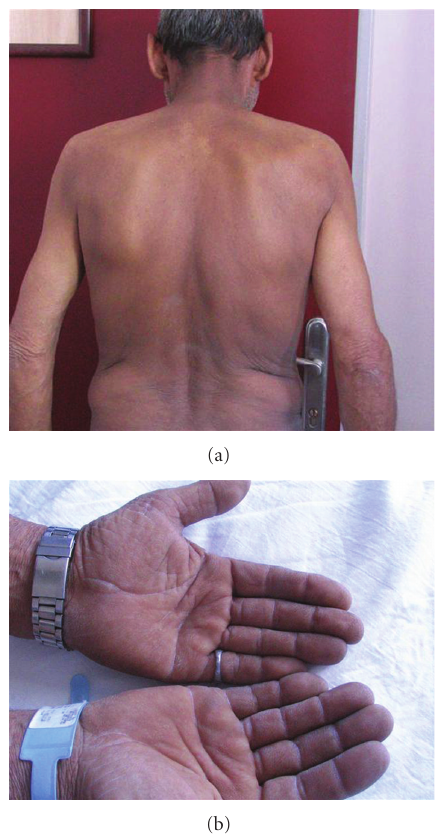
Figure 2: Hyperpigmentation in the back and hands.